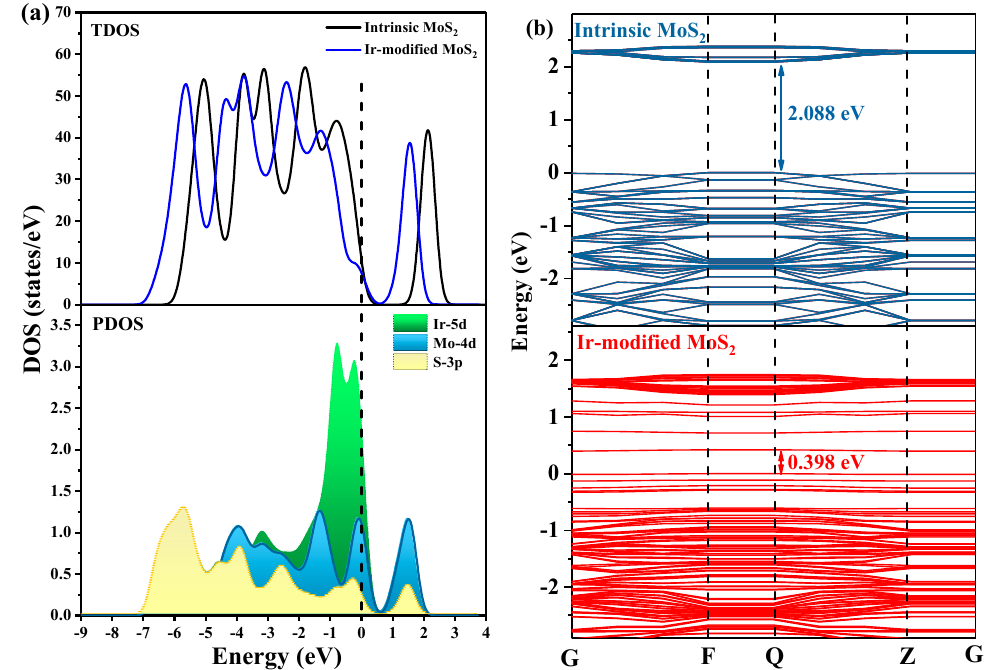
Figure 2. The ( a ) DOS distributions and ( b ) band structure of the intrinsic and Ir-modified MoS 2 systems.